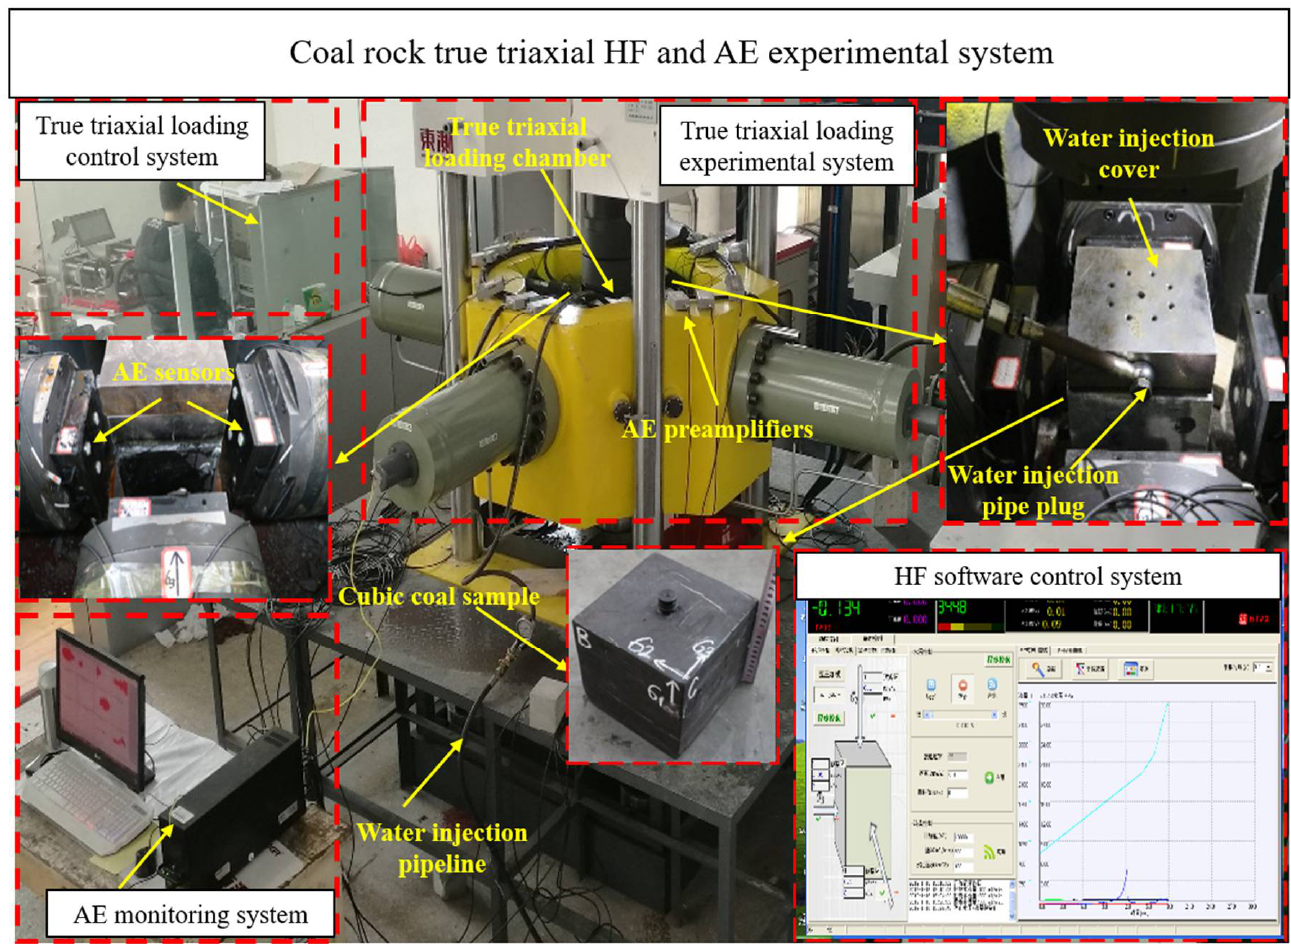
Figure 1. Coal rock true triaxial HF and AE experimental system.